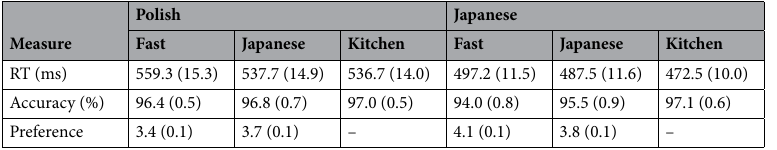
Table 1. Mean (with standard error) reaction time (RT), percent accuracy, and preference ratings for fast food, Japanese food, and kitchen tools by Polish and Japanese participants.